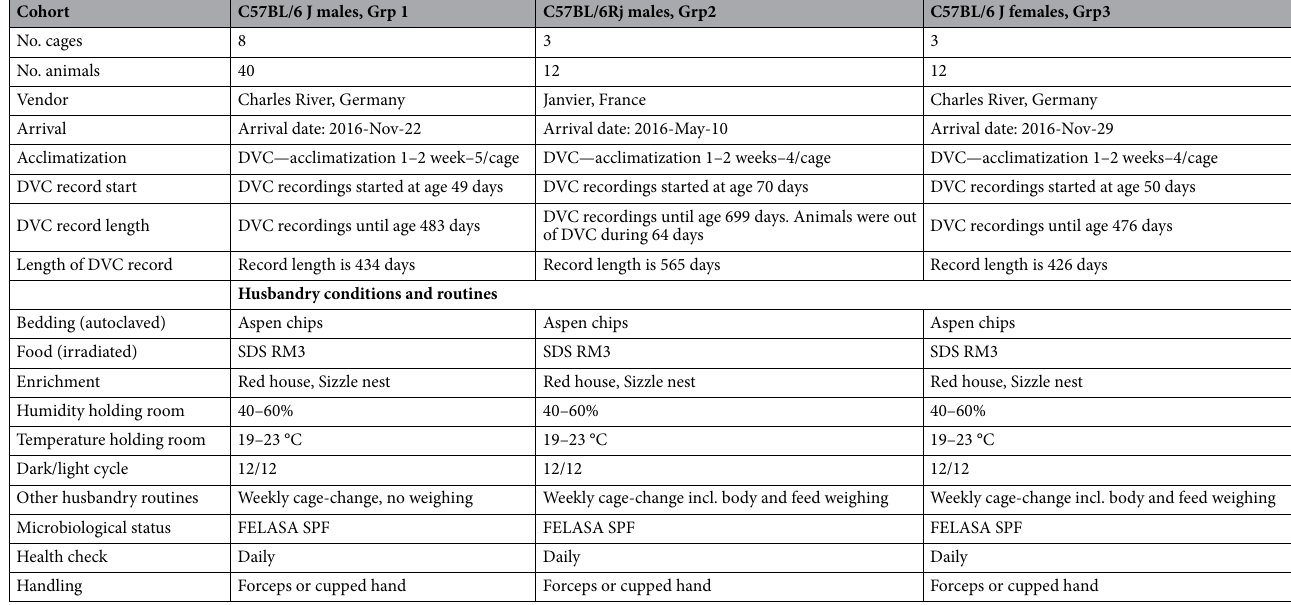
Table 1. Table of animals used, grouping, DVC recordings and husbandry